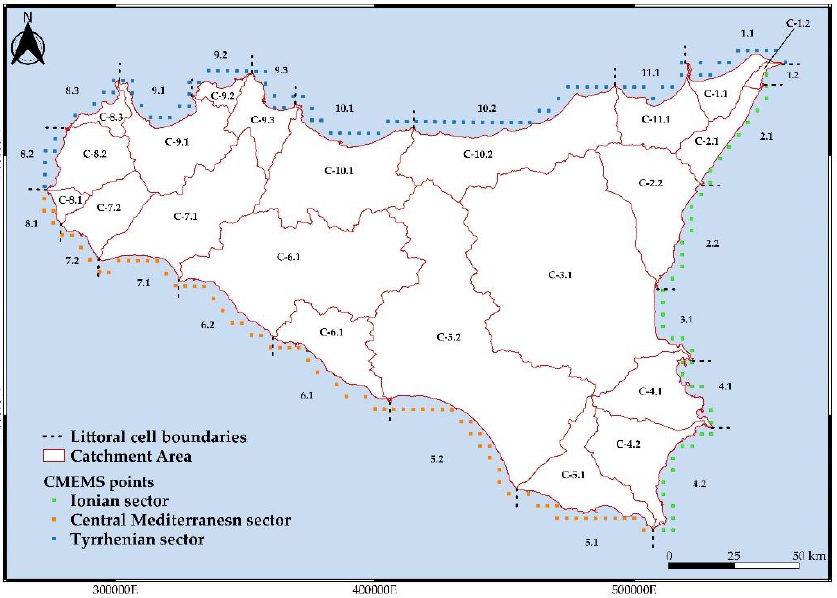
Figure 5. Sicilian hydrograph catchments related littoral cells and relative CMEMS points (EPSG: